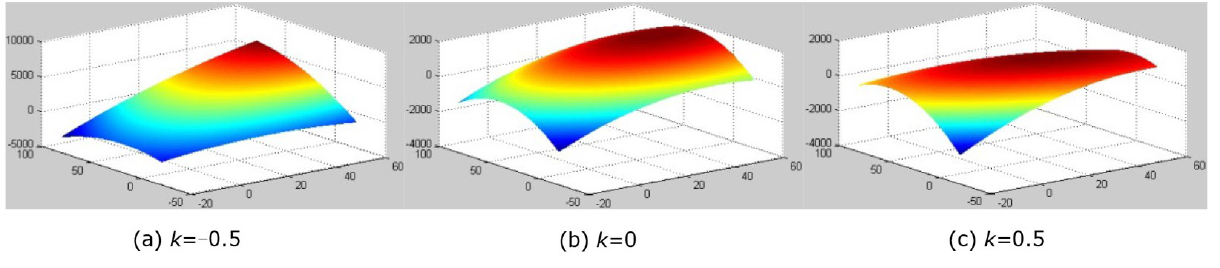
Figure 2. Relationship between the Effort Level of Knowledge